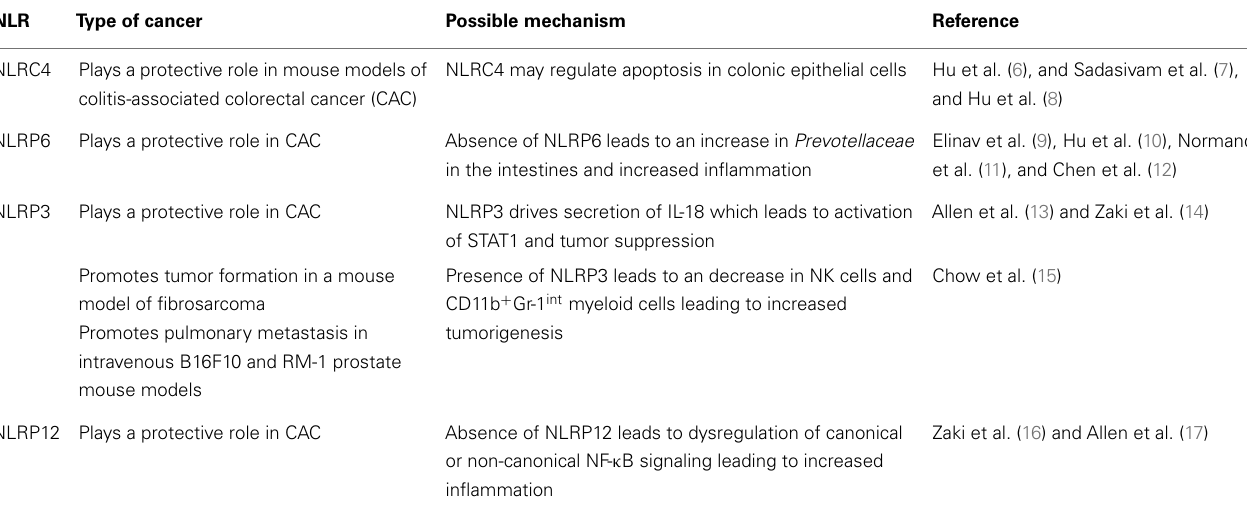
Table 1 | Role of NLRs in